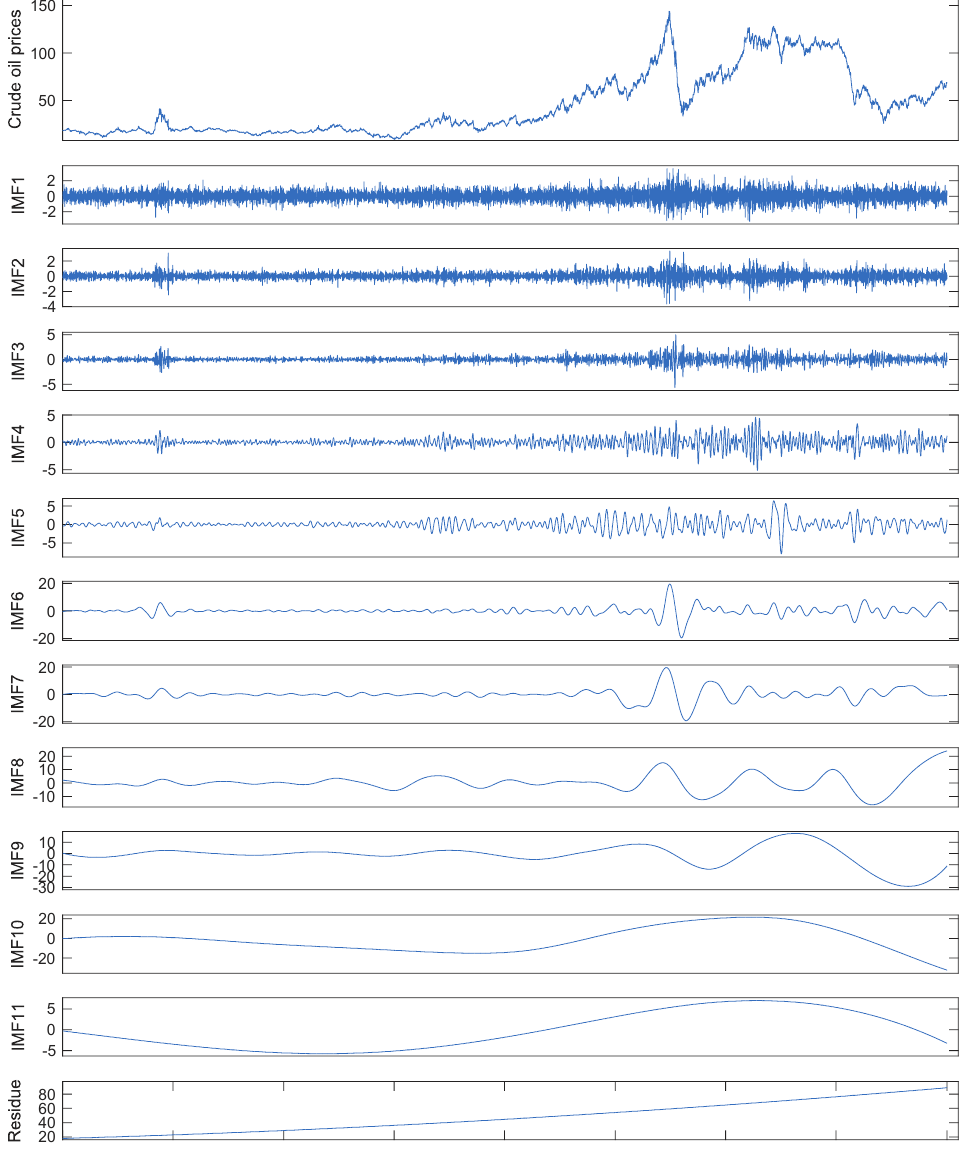
Figure 3. The original data and corresponding components decomposed by EEMD of Brent crude oil prices. IMF: intrinsic mode